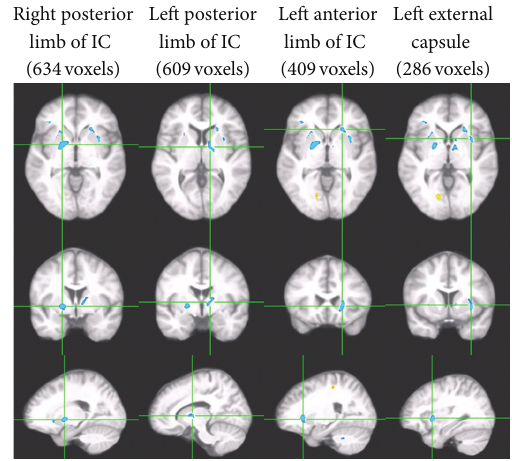
Figure 1: Four largest clusters all demonstrating significant WM FA reductions (clusters in blue) among HTN participants relative to normotensive participants (VANCOVA analyses controlling for age, bodymassindex(BMI),adiagnosisofT2DM,andtheFLAIRimage; significance shown for a minimum cluster size of 100 contiguous voxels; 𝑃 < 0.01 ). Each column shows three orthogonal orientations of the average normalized structural image illustrating a significant cluster with axes passing through the centroid of the cluster (the Talairach space coordinates for the clusters are listed on Table